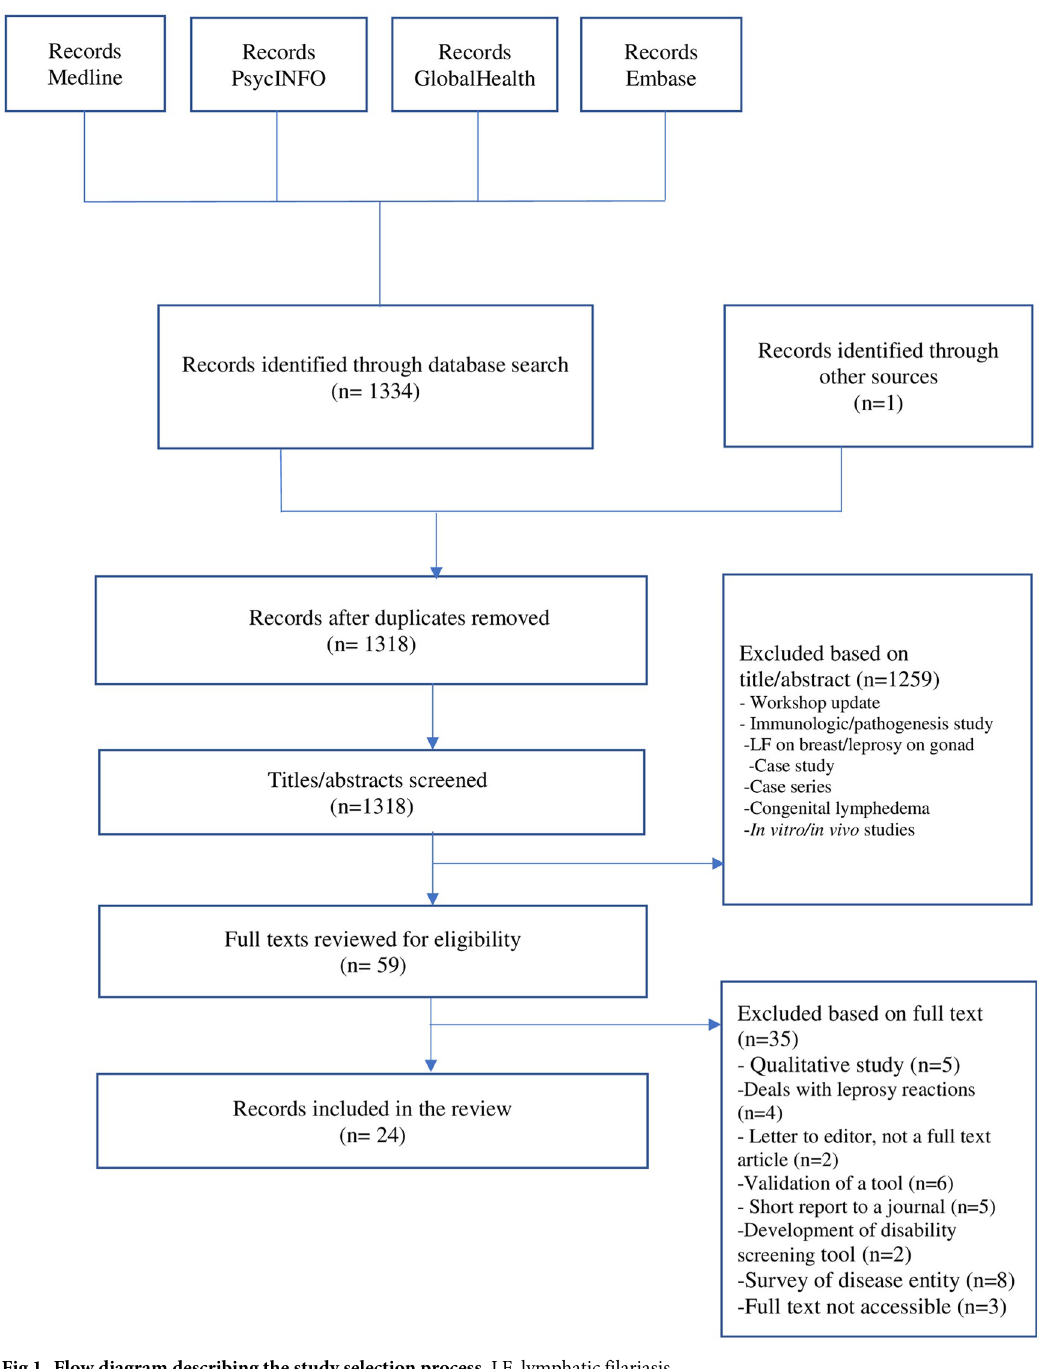
Fig 1. Flow diagram describing the study selection process. LF, lymphatic